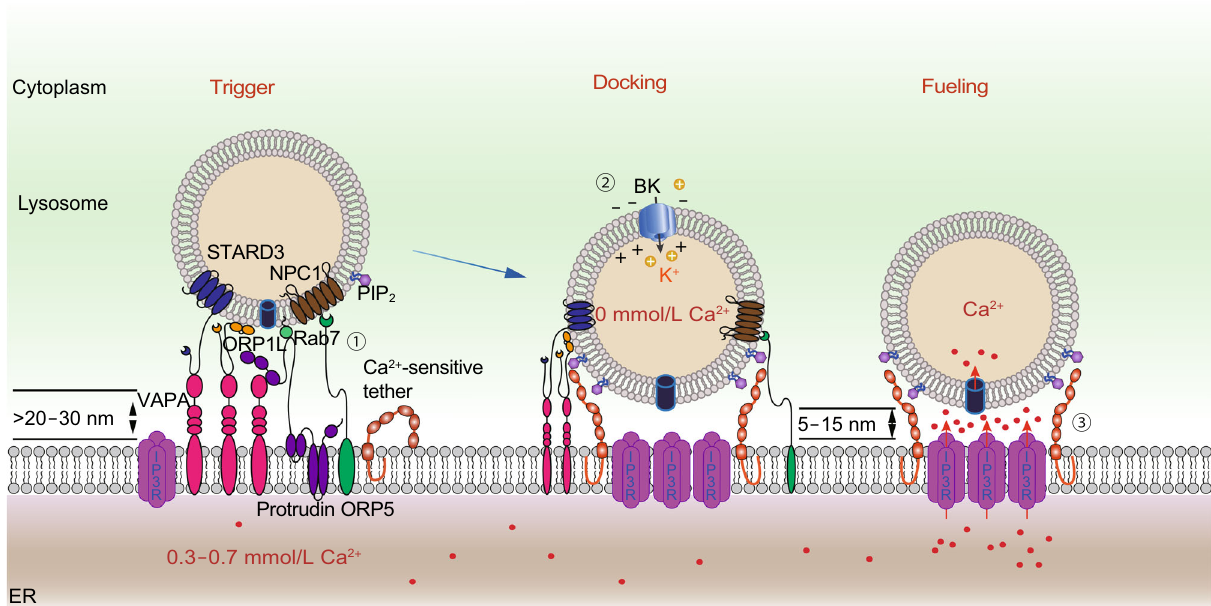
Figure 2. A three-step working model of lysosomal re fi lling. Lysosome Ca 2+ stores are depleted upon cellular stimulation triggering lysosomal Ca 2+ release. An increase in juxta-lysosomal [Ca 2+ ] Cyt or a decrease in [Ca 2+ ] Ly triggers re fi lling. In the docking step, MCSs are formed by both constitutive tethers, including endolysosome-localized ORP1L, STARD3, Protrudin, NPC1, and ER- localized ORP5, and VAP ([vesicle-associated membrane protein]-associated ER protein), as well as by putative Ca 2+ -sensitive tethers (e.g., E-syt1). In the fueling step, ER and lysosomal membranes are brought closer (within 5 nm). Meanwhile, both IP3Rs